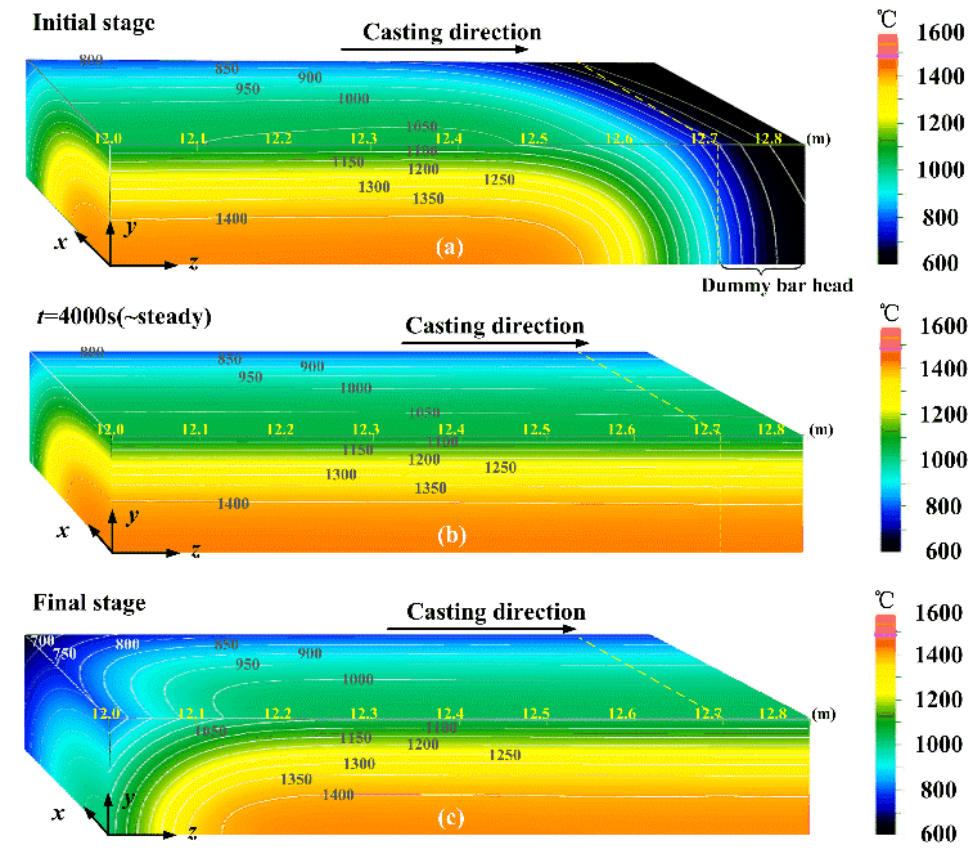
Figure 4. Calculated time-variant temperature field. ( a ) Initial stage; ( b ) after 4000 s; ( c ) final stage.